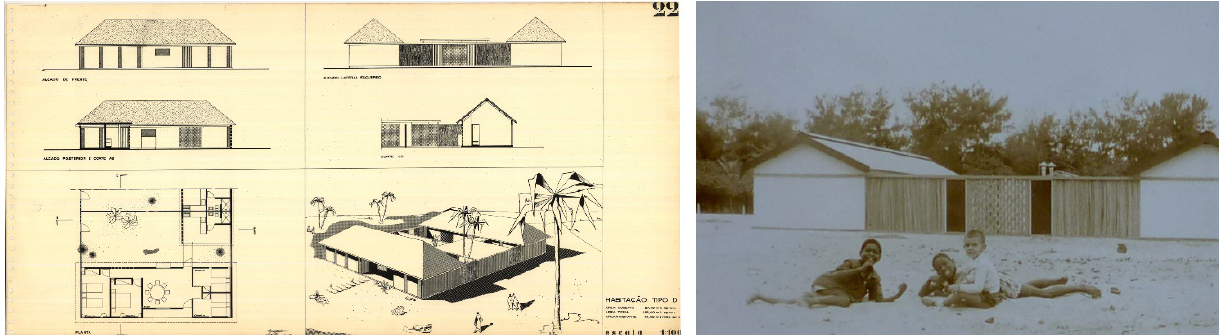
Figure 1. Fishermen’s District in Luanda: Housing type D (left) and model houses (right). Sources: Carvalho and Cunha (1963; left) and courtesy of Fernão Simões de Carvalho